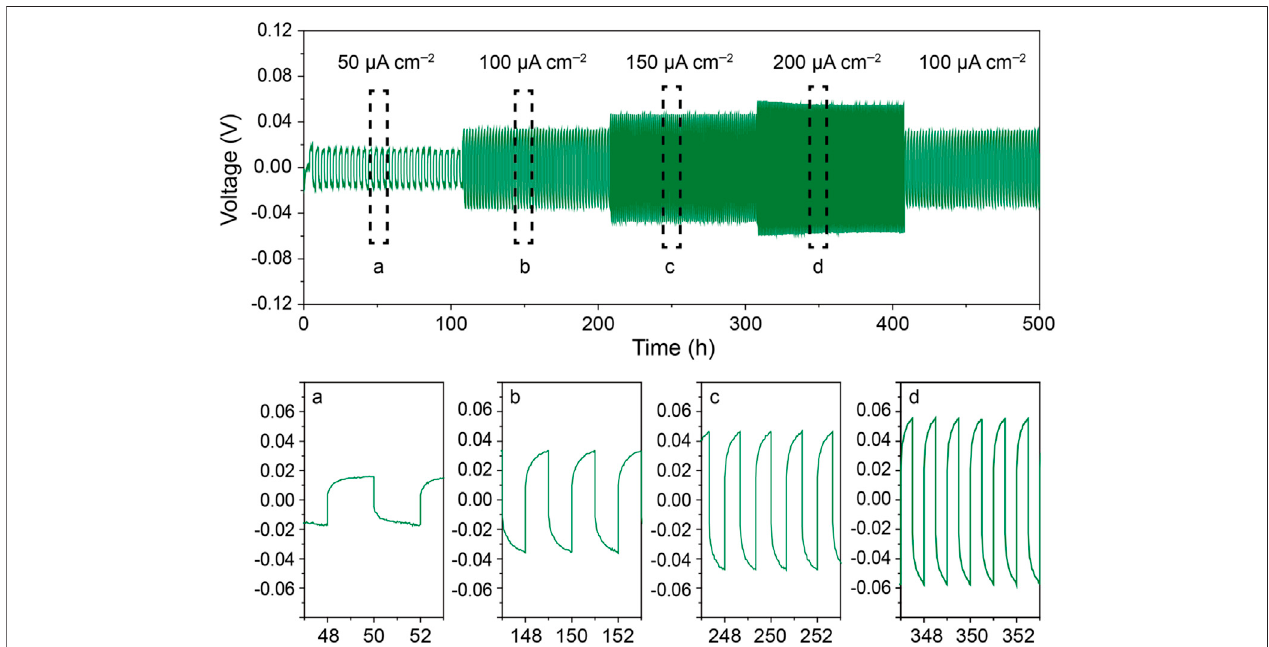
FIGURE 4 | The voltage pro fi le of a Li/CPE-10/Li battery cycled at 40 ° C under different current densities.